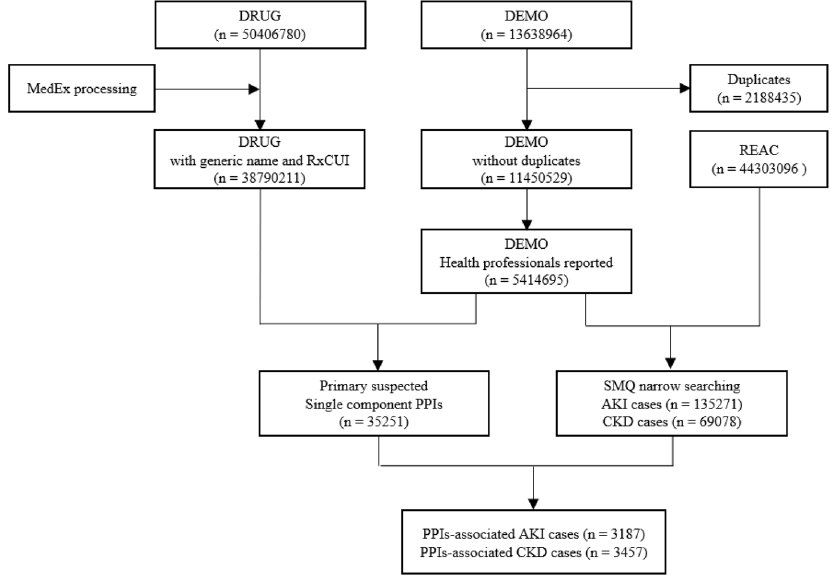
Figure 1. Flow chart of identifying PPI associated AKI and CKD cases from FAERS